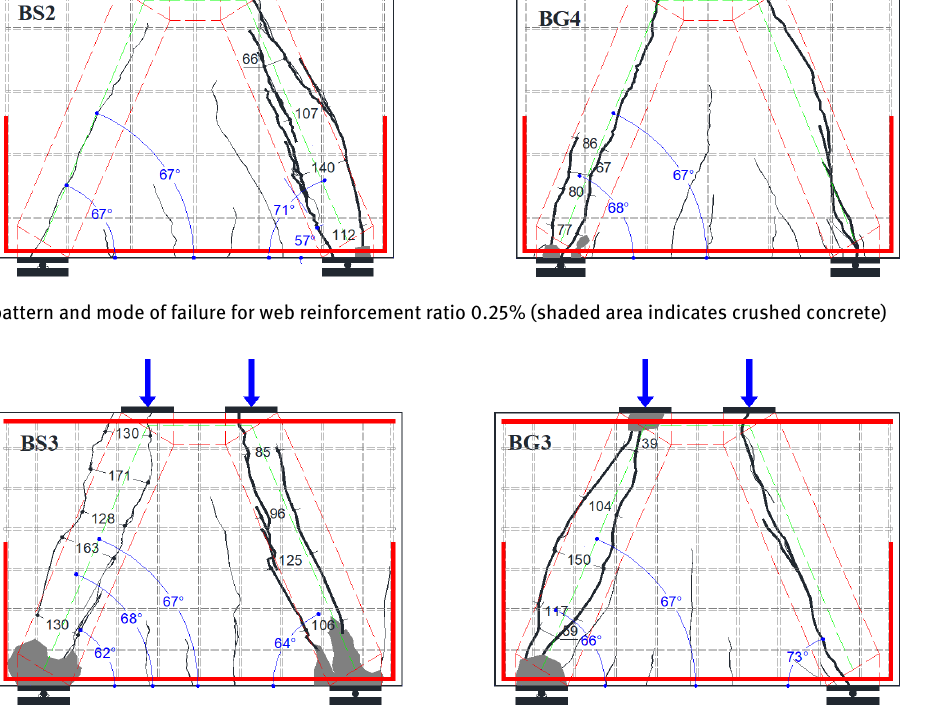
Figure 29: Crack pattern and mode of failure for web reinforcement ratio 0.40% (shaded area indicates crushed